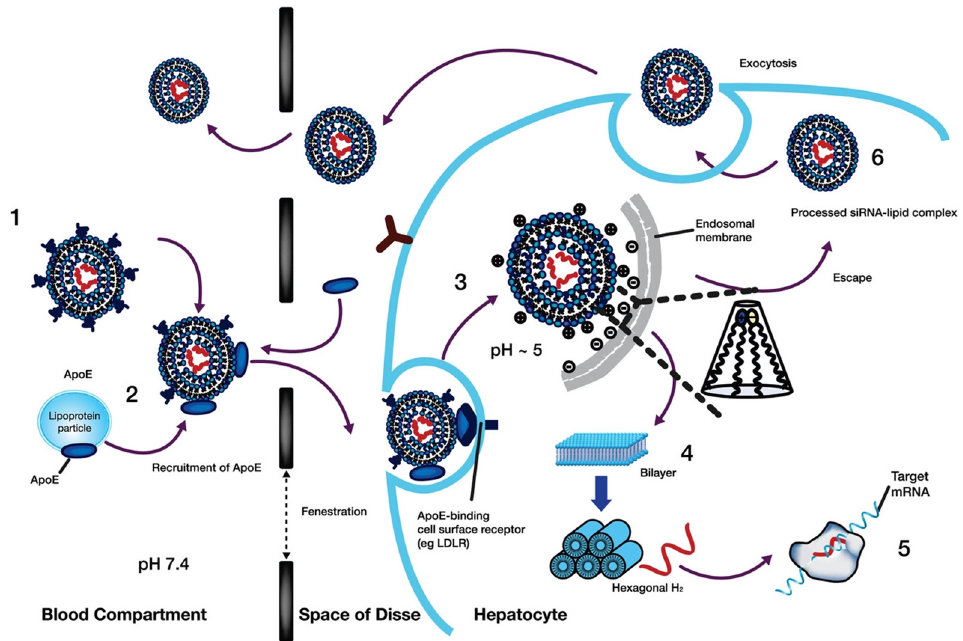
Figure 11. Proposed mechanism of action for Patisiran LNP. (1) Dissociation of PEG 2000 -C-DMG from LNP after IV administration. (2) Removal of the PEG followed by ApoE- dependent process, thereby facilitating uptake of LNP into hepatocytes. (3) Endocytosis-mediated internalization, ionization of DLin-MC3-DMA lipid as a result of decrease in pH in endosome. (4) Destabilization of endosomal membrane resulting from interaction of positively charged DLin-MC3-DMA lipid with the negatively charged endosomal membrane lipid, as a result LNP disintegrates, releasing ALN-18328 into the cytoplasm. (5) The released ALN-18328 binds to RISC, which then degrades the target TTR mRNA and subsequently reduced the levels of target protein. (6) Exocytosis of remaining proportion of LNPs, departure from late endosomes or lysosomes into the circulation. Adopted from ref. [195], J. Clin. Pharmacol. 2020.